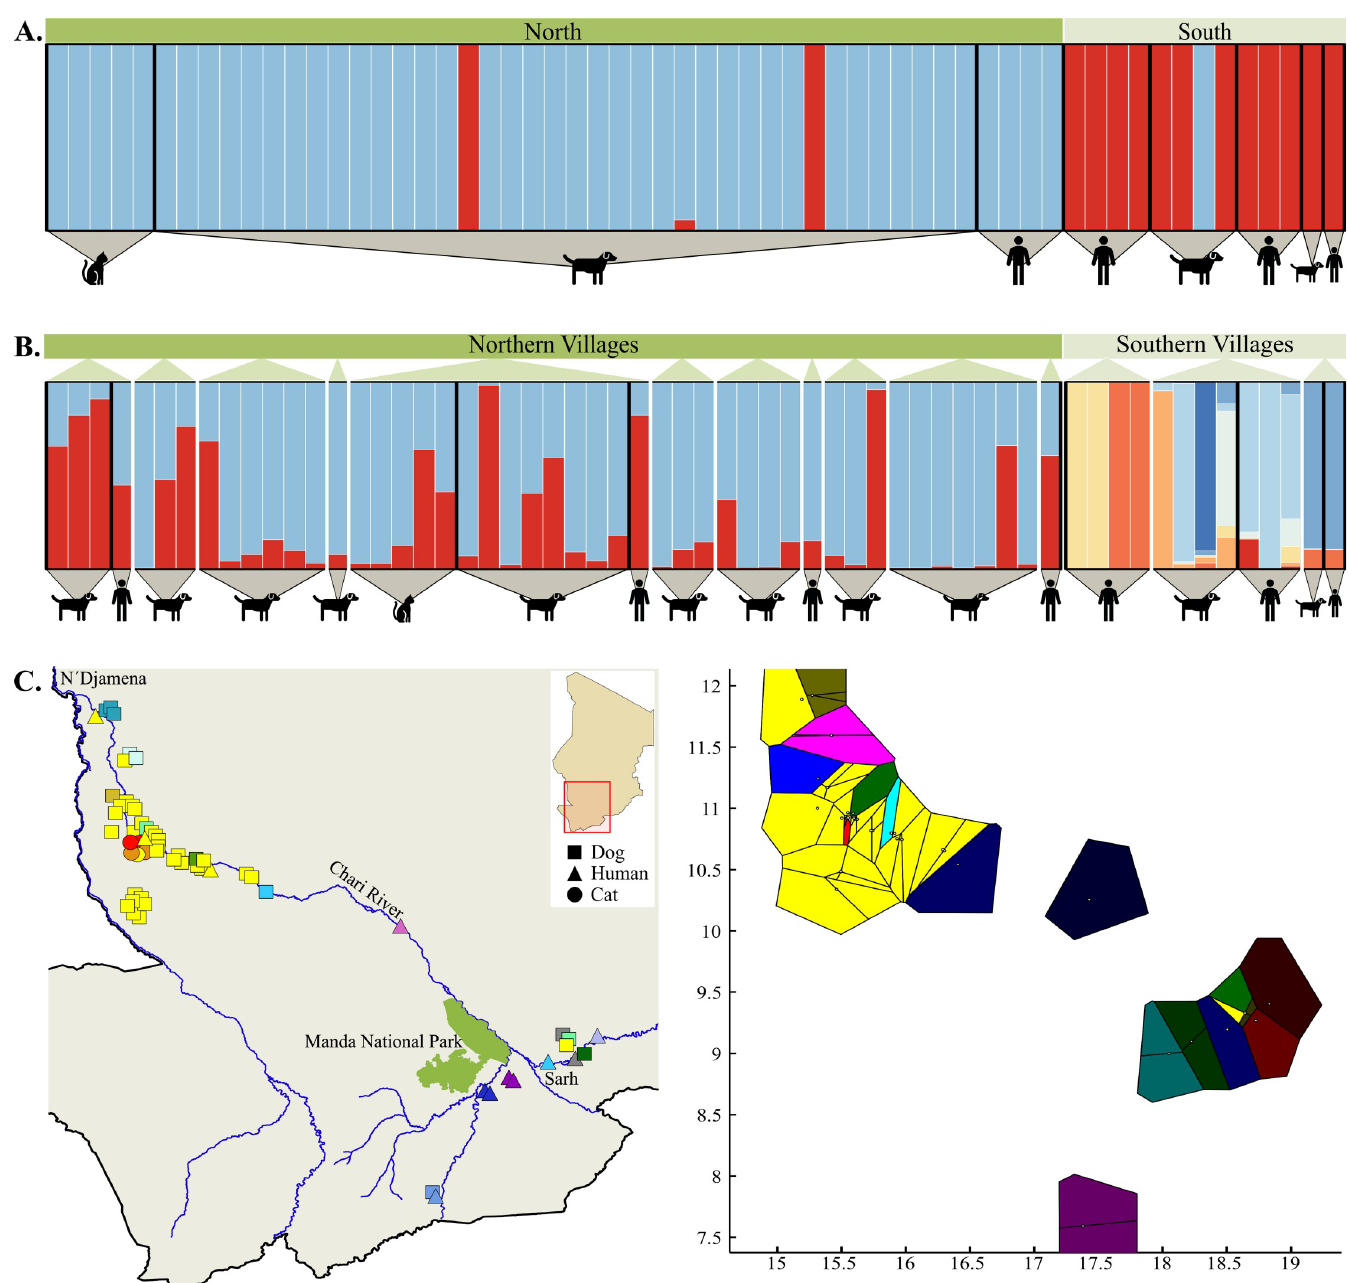
Fig 6. Inference of D . medinensis subdivision among host species and geographic regions within Chad. (A) Posterior assignment of all D . medinensis worms collected from within Chad into K = 2 clusters of shared ancestry, as inferred using the TI method in MavericK v1.0 to determine most likely K [26]. Each bar represents an individual worm and color indicates proportional assignment to one or more clusters. Individuals have been sorted by geographic region (i.e., north or south of Manda National Park) and definitive host species. (B) Assignment of worms when analysis is restricted by broad geographic region (i.e., north or south of Manda National Park) in MavericK v1.0. Northern worms were assigned into K = 2 clusters and worms from southern villages into K = 8 clusters. Within each geographic region, worms are sorted by village and definitive host species. Bar colors are only informative within each assignment analysis and should not be used for comparison among them. (C) Spatial clustering of individuals in BAPS v6.0 for most likely K = 16. Individual parasites plotted onto the map of the sampling area is depicted on the left, and Voronoi tessellation of clusters is illustrated on the right. Mapped point shape indicates host species and color indicates the cluster to which an individual was assigned. The map was generated with QGIS v2.18.13 [46]. River paths and national park boundaries were extracted from Landsat 8 imagery provided courtesy of the U. S. Geological Survey (http://glovis.usgs.gov/). Note that the cluster coloring scheme is not uniform between the mapped points and tessellation.